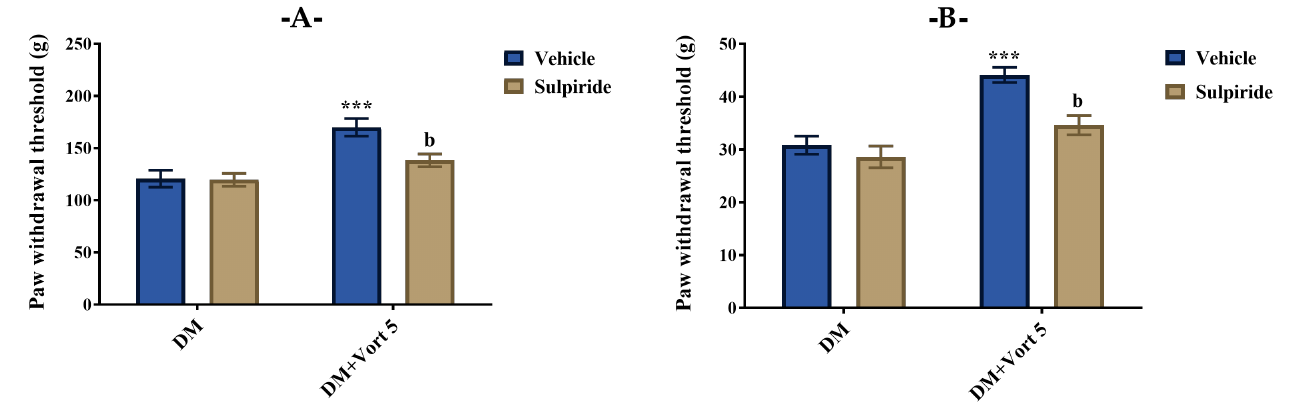
Figure 9. The effects of sulpiride pre-treatment on antihyperalgesic ( A ) and antiallodynic ( B ) re- sponses induced by the administration of 5 mg/kg vortioxetine in the Randall–Selitto and Dy- namic plantar tests, respectively. Values are given as mean ± S.E.M. Significant difference against vehicle-administered diabetic group (DM) *** p < 0.001; significant difference against vortioxetine- administrated diabetic group (DM+Vort 5) b p < 0.01. Two-way ANOVA, post hoc Bonferroni multiple com- parison test, n = 8.